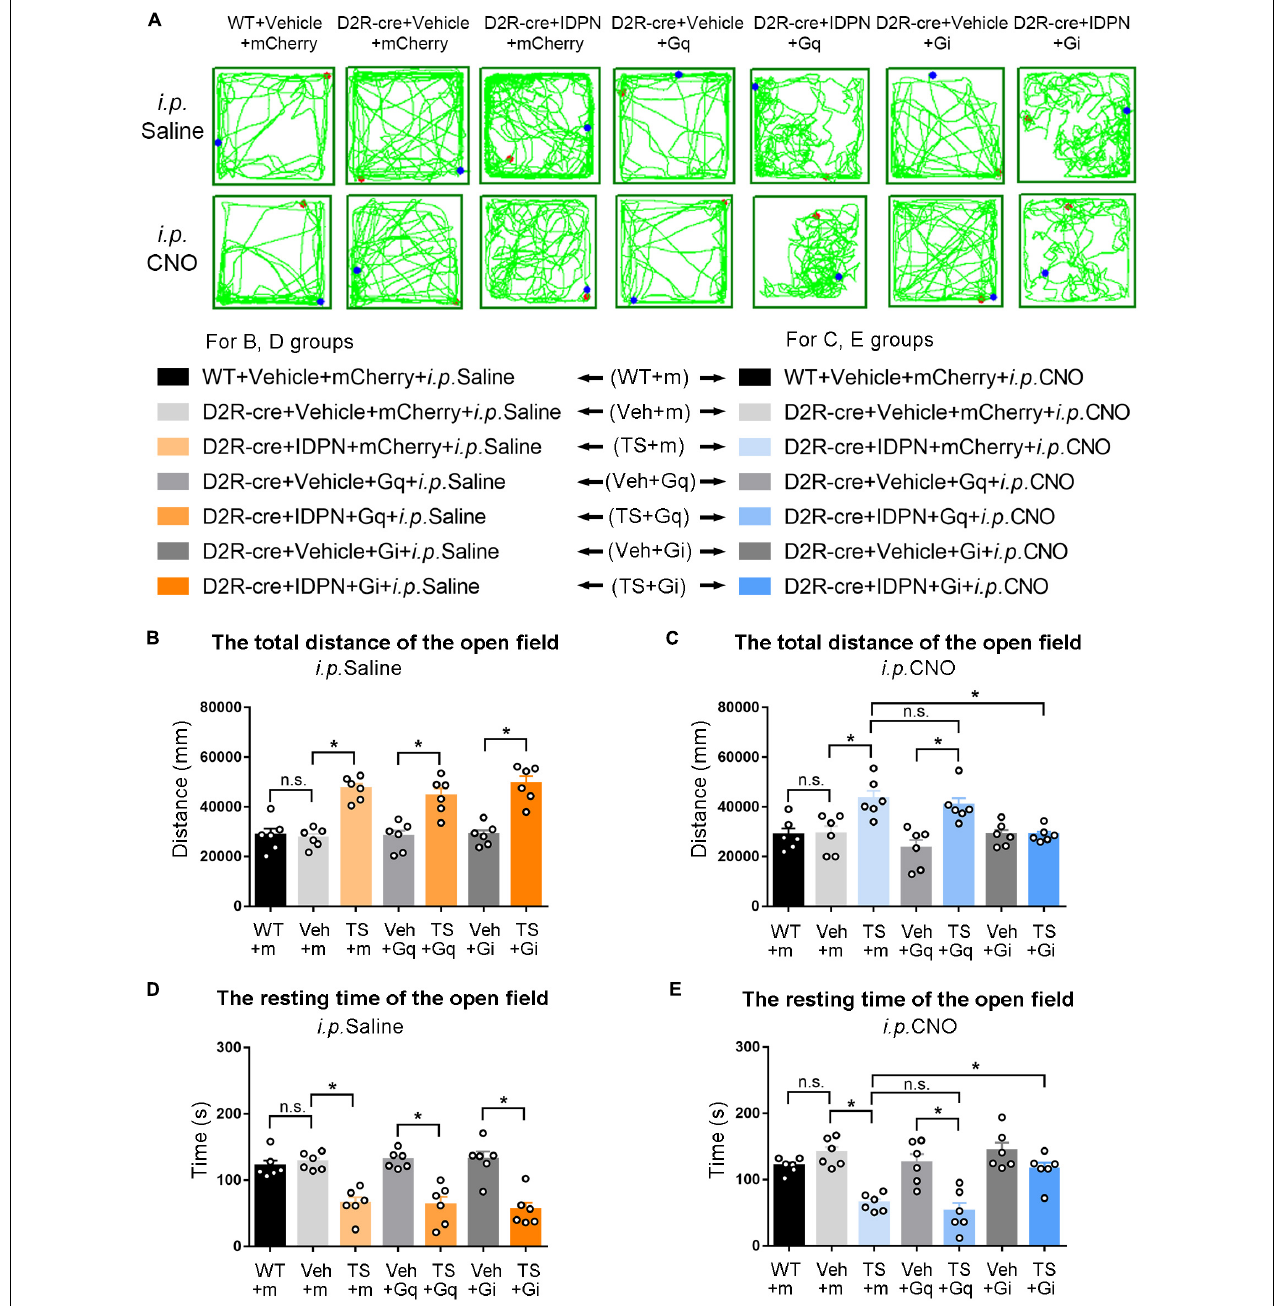
FIGURE 7 | Effects of activation or inhibition of D2R-containing neurons in the dSTR on total distance and resting time in the open-field test in mice. (A) Evaluations of the trajectory in the open-field test in mice 30 min after the injection of saline (i.p. Saline) or CNO (i.p. CNO) in the WT + Vehicle + mCherry + i.p. Saline group (WT + m), D2R-cre + Vehicle + mCherry + i.p. Saline group (Veh + m), D2R-cre + IDPN + mCherry + i.p. Saline group (TS + m), D2R-cre + Vehicle + Gq + i.p. Saline group (Veh + Gq), D2R-cre + IDPN + Gq + i.p. Saline group (TS + Gq), D2R-cre + Vehicle + Gi + i.p. Saline group (Veh + Gi), D2R-cre + IDPN + Gi + i.p. Saline group (TS + Gi), WT + Vehicle + mCherry + i.p. CNO group (WT + m), D2R-cre + Vehicle + mCherry + i.p. CNO group (Veh + m), D2R-cre + IDPN + mCherry + i.p. CNO group (TS + m), D2R-cre + Vehicle + Gq + i.p. CNO group (Veh + Gq), D2R-cre + IDPN + Gq + i.p. CNO group (TS + Gq), D2R-cre + Vehicle + Gi + i.p. CNO group (Veh + Gi), D2R-cre + IDPN + Gi + i.p. CNO group (TS + Gi) on day 23. (B) Total distance in the open-field test within 10 min in mice of each group 30 min after the injection of saline (i.p. Saline) on day 23. (C) Total distance in the open-field test within 10 min in mice of each group 30 min after the injection of CNO (i.p. CNO) on day 23. (D) Resting time in the open-field test within 10 min in mice of each group 30 min after the injection of saline (i.p. Saline) on day 23. (E) Resting time in the open-field test within 10 min in mice of each group 30 min after the injection of CNO (i.p. CNO) on day 23. Data are expressed as mean ± SEM ( n = 6 mice in each group), and the black line segment indicates the differences between groups, * represents P < 0.05 between marked groups, and n.s. represents P > 0.05 between marked groups.